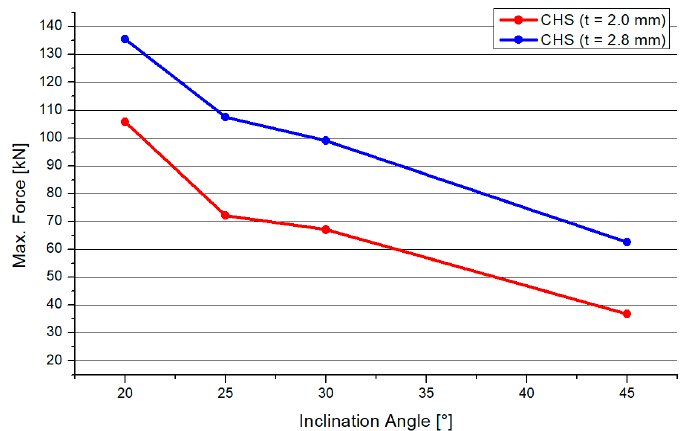
Figure 9. Comparison of the results of both CHS profiles.